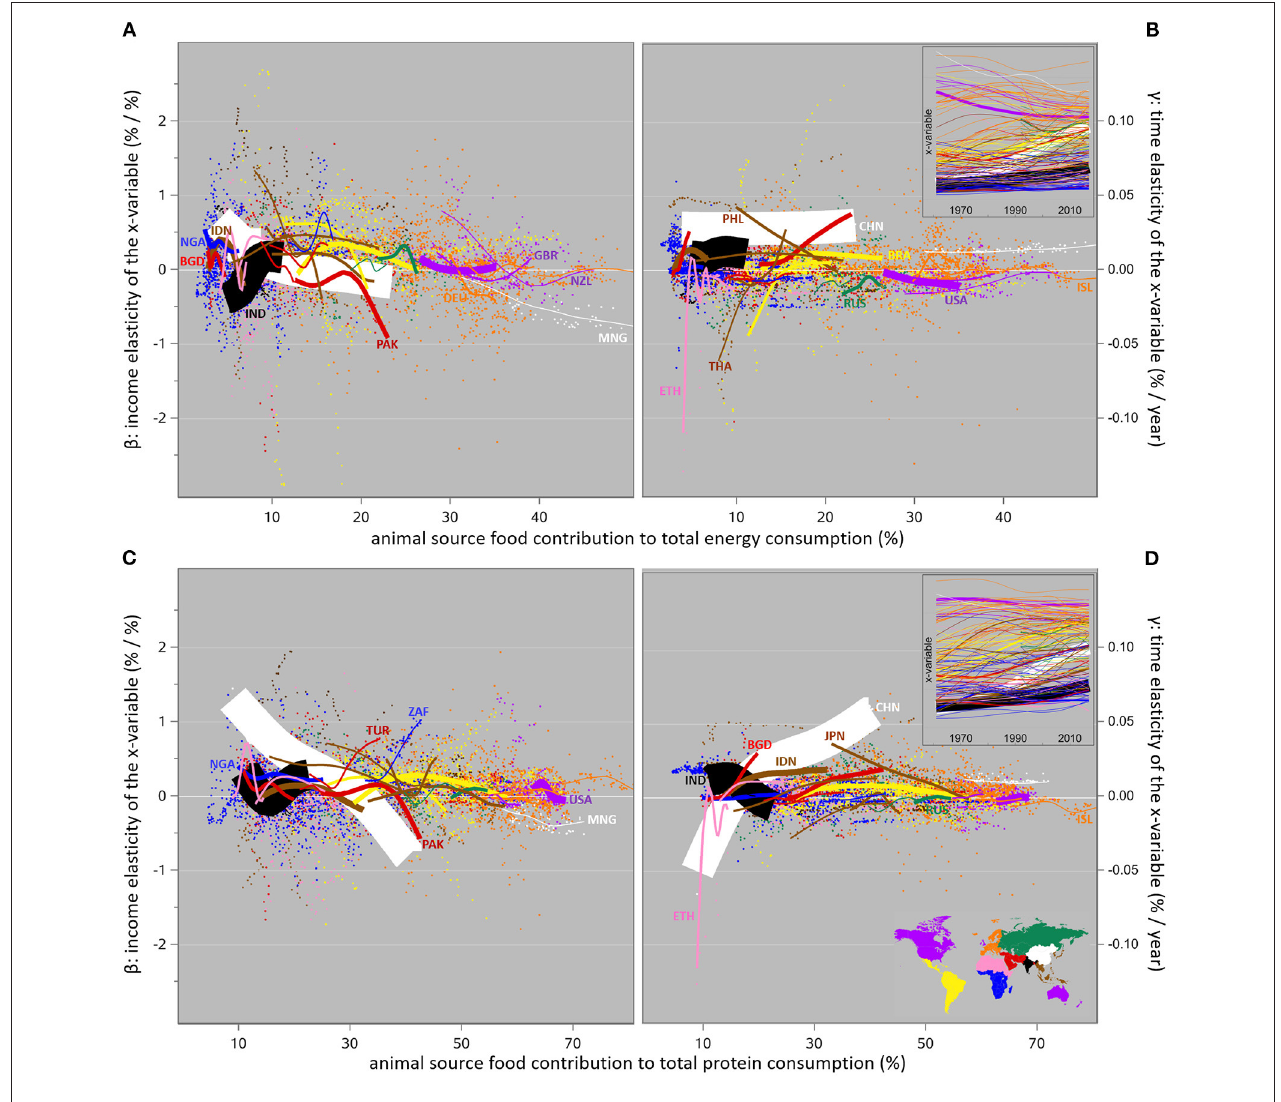
FIGURE 7 | Regression coefficients of the logarithm of the proportions of daily energy (A,B) or protein (C,D) consumption that are based on animal source food, on the logarithm of annual income ( β : the income elasticity , adjusted for time-related non-income effects), and on time and its associated non-income effects ( γ : the time elasticity , adjusted for income effects), from 1961 to 2017. Note that the x-axes show the actual contribution% levels, not time or income; the time trends of the x-variable are shown in the insets. See Figure 6 for details on the